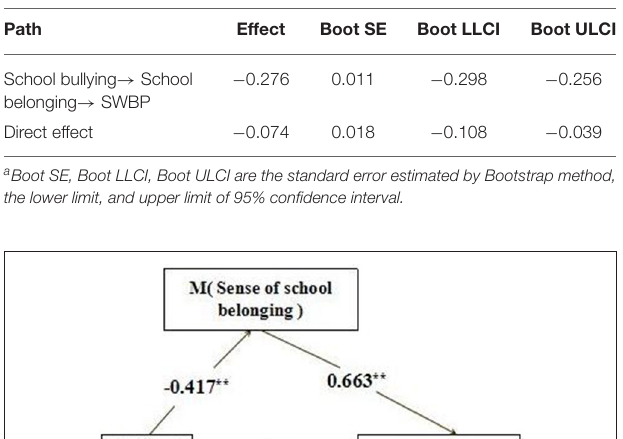
TABLE 3 | The direct effect of school bullying and the mediating effect of school belonging a .